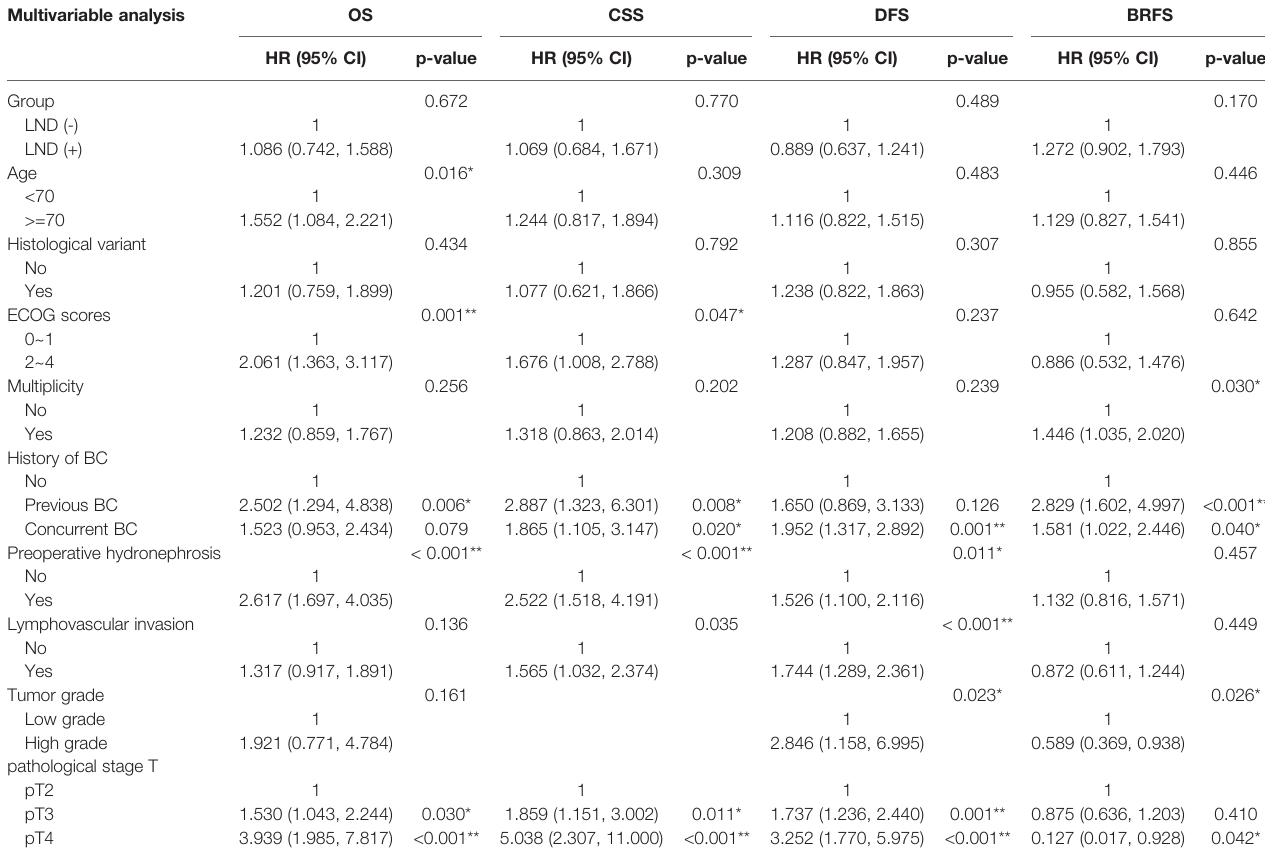
TABLE 3 | Comparative multivariate survival analysis of UTUC patients receiving NU. Multivariable